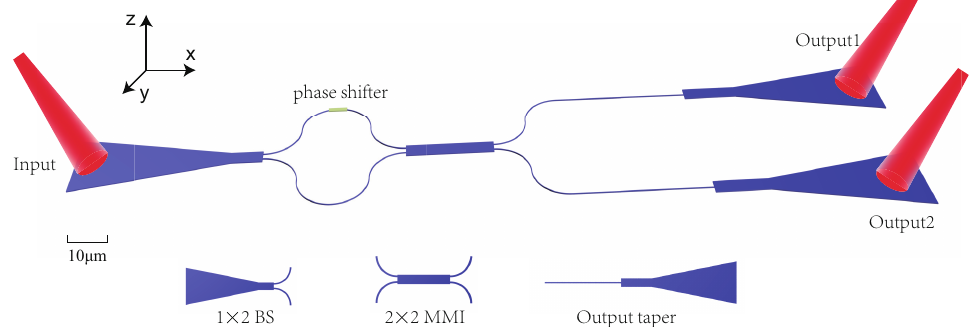
Figure 1. The schematic of the proposed Mach–Zhnder interferometer which mainly contains a 1 × 2 beam splitter, a phase shifter, a 2 × 2 beam splitters, and two output tapers. The length of 1 × 2 BS, output taper, and the footprint of 2 × 2 MMI are 24.1µm, 27.2µm, and 2 × 11.6µm 2